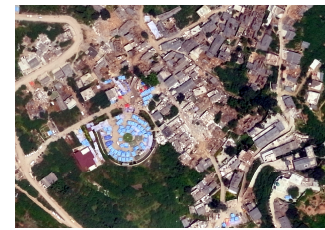
Figure 7. Aerial photograph in LongTouMountain-town of Ludian acquired after Ludian earthquake